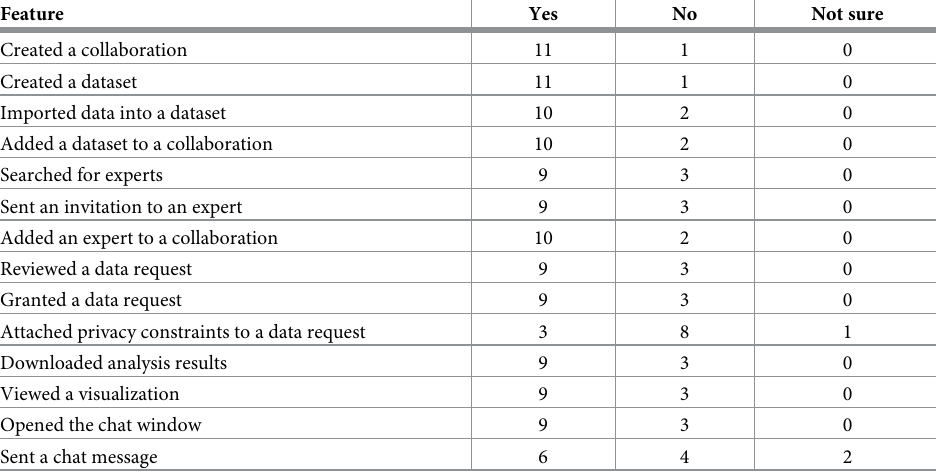
Table 3. Number of survey respondents by level of previous experience in lifelogging and knowledge discovery. Subject 1 Lifelogging Knowledge discovery The respondents were asked to self-rate their level of experience on a discrete 1–5 scale where 1 = little or no experience, 5 = highly experienced.